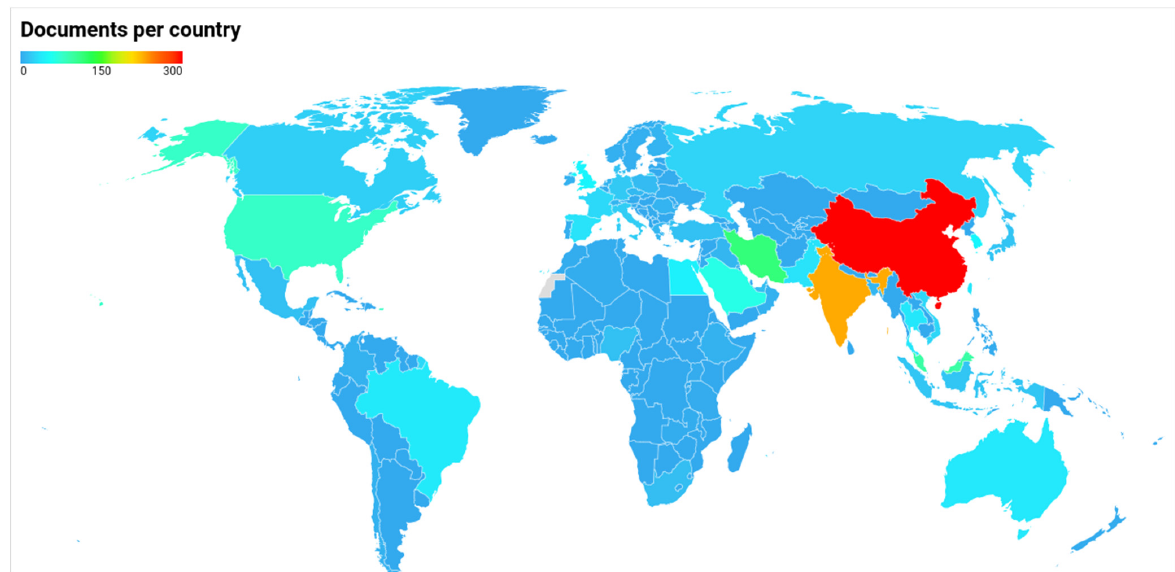
Figure 4. Documents per country.